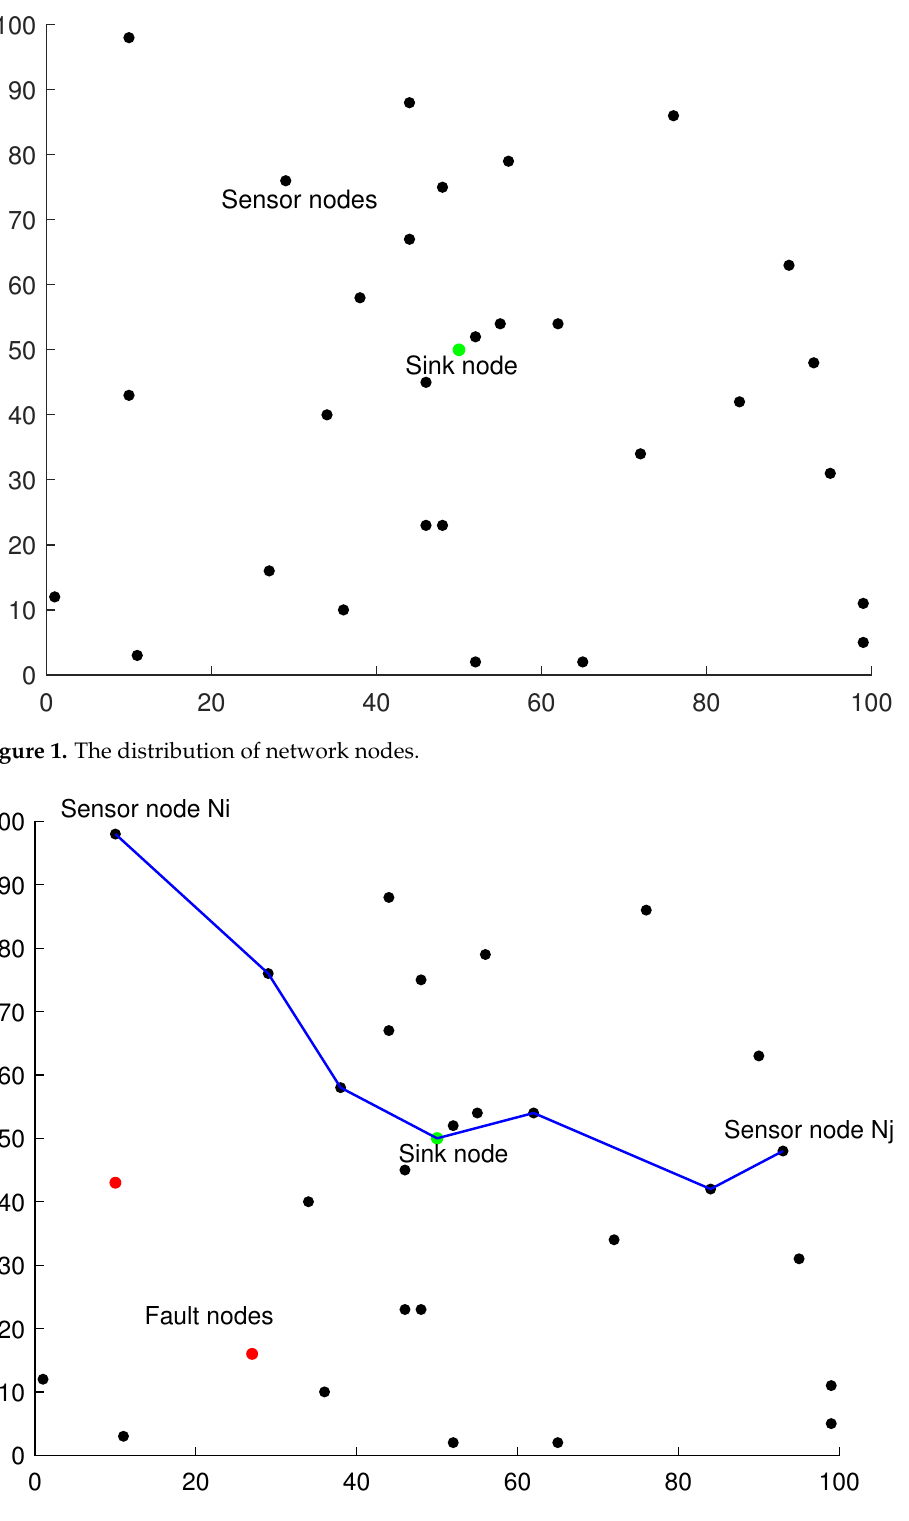
Figure 2. The routing path from sensor node N i to sensor node N j through the sink